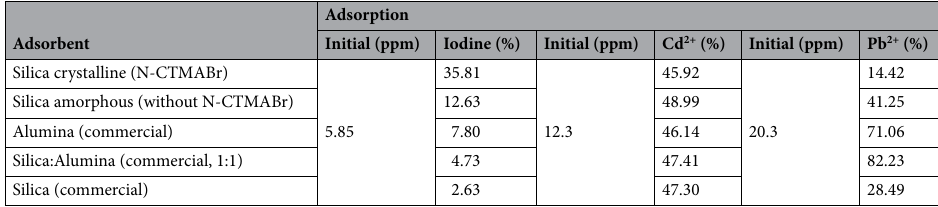
Table 5. Iodine, cadmium (II) and lead (II) adsorption of silica/alumina materials.